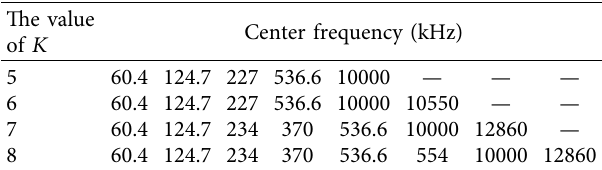
Table 3: Center frequencies of different decomposition layers. The value of